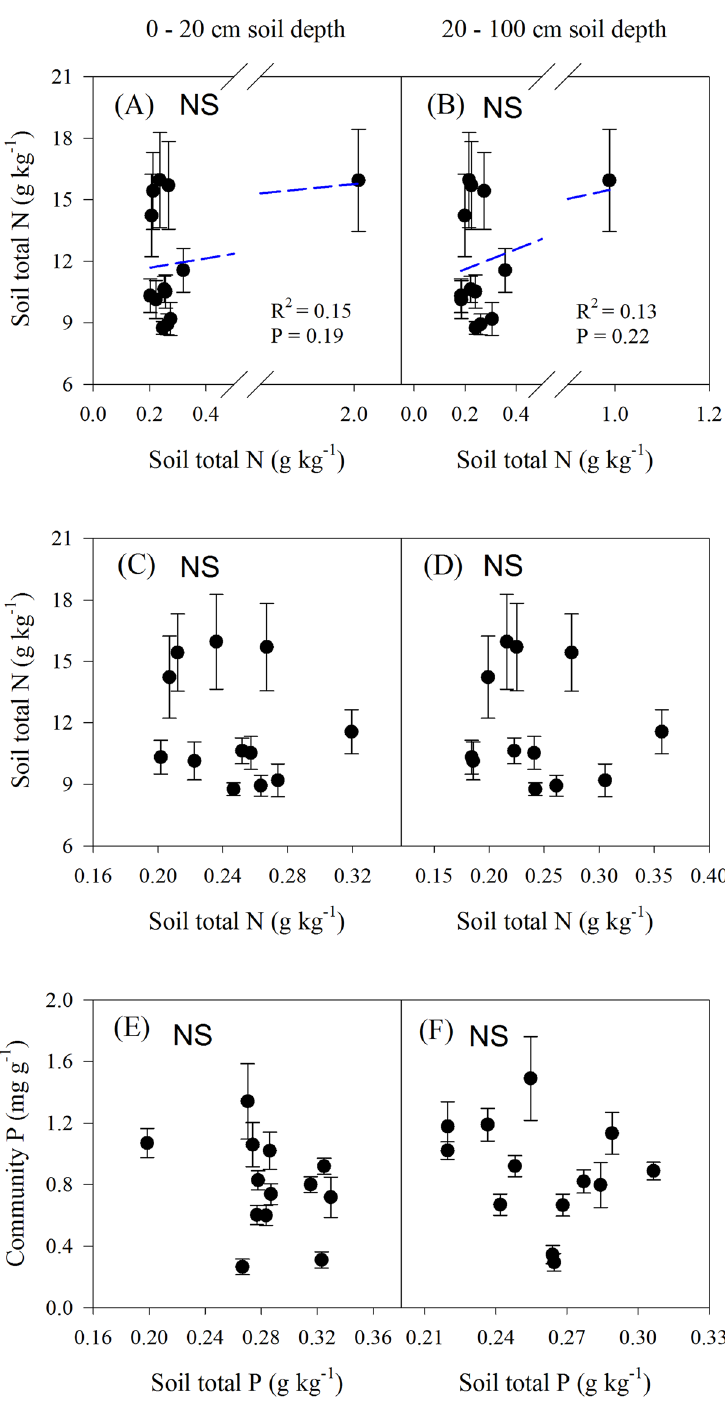
Figure 5. Relationships between plant community nutrients and soil nutrients across the transect. Blue solid lines represent the fitted linear regressions. Figures C and D excluded the data on soil total N at site 8 (the data were higher than others and influenced the result of the linear regression